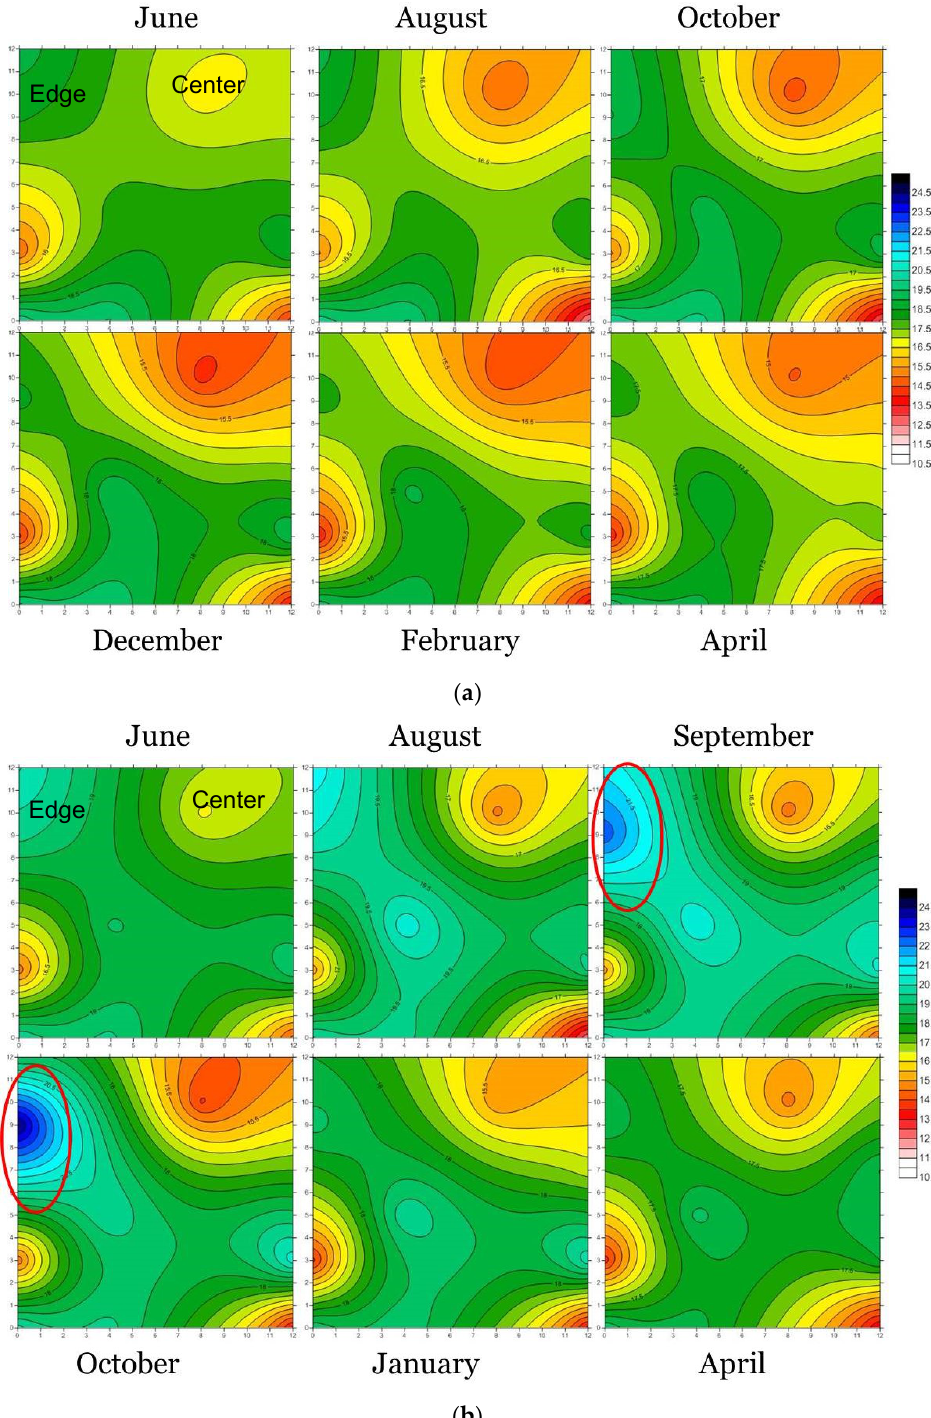
Figure 5. Bi-monthly ( a ) average moisture content and ( b ) maximum moisture content contour in pavement section.